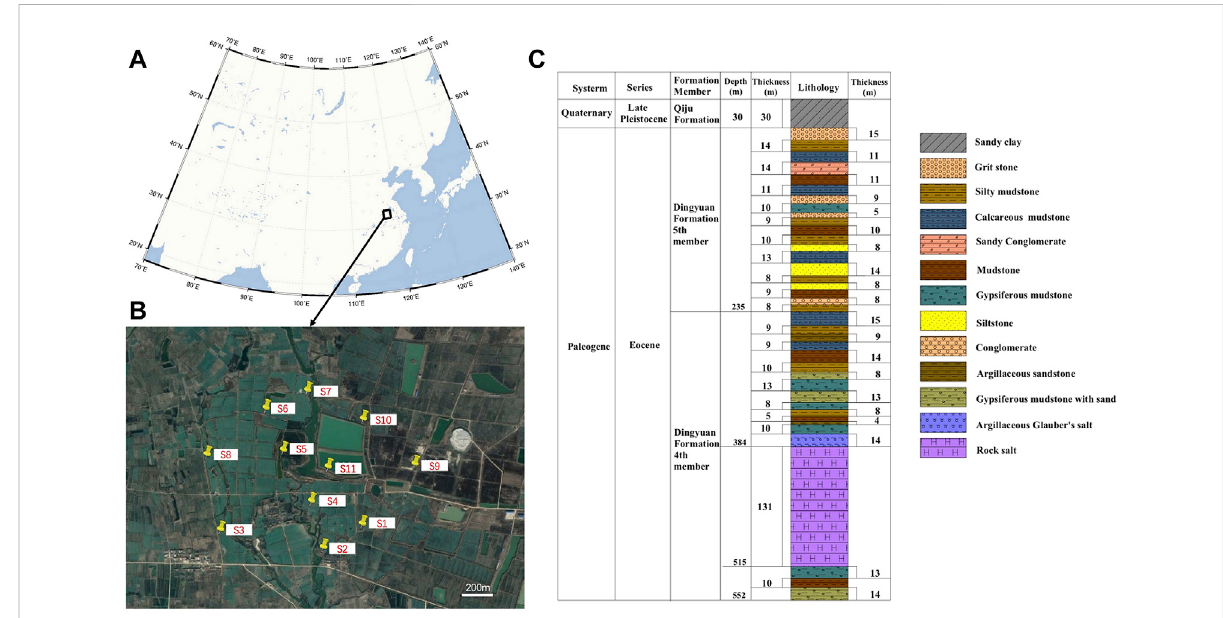
FIGURE 1 (A) The geographic location of the Dongxing salt mine in eastern China. (B) The distribution of surface geophones of the microseismic monitoring system. (C) Stratigraphic column of the Dongxing salt mine (modi fi ed after Zhang et al., 2018).